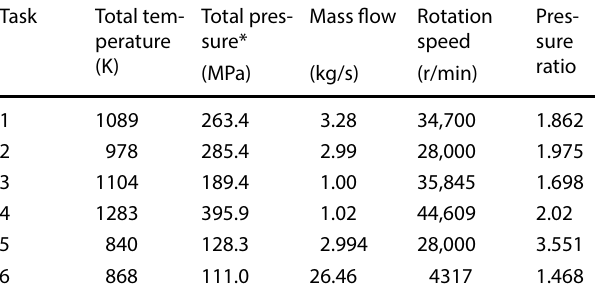
Table 1 Turbine source task design requirements